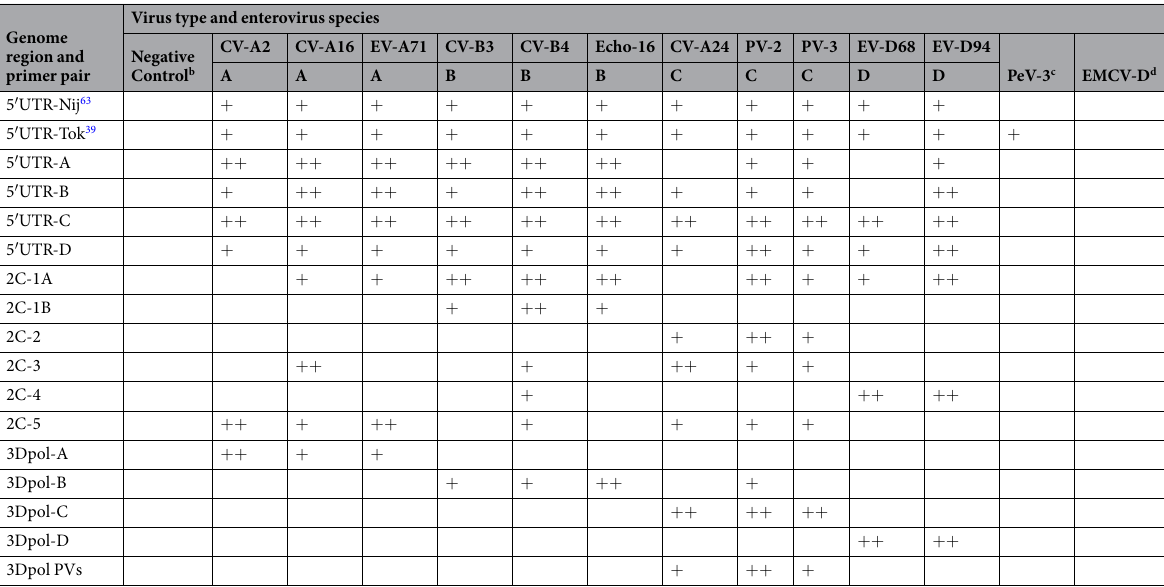
Table 1. Specificity of enterovirus primer pairs: RT-PCR amplification of enterovirus belonging to the A, B, C, D species and picornaviruses other than EVs a . a Intensity of electrophoretic bands: blank, no band; + , medium; ++ , strong. Data shown represent the results of PCR assays performed in duplicate. b Supernatant of